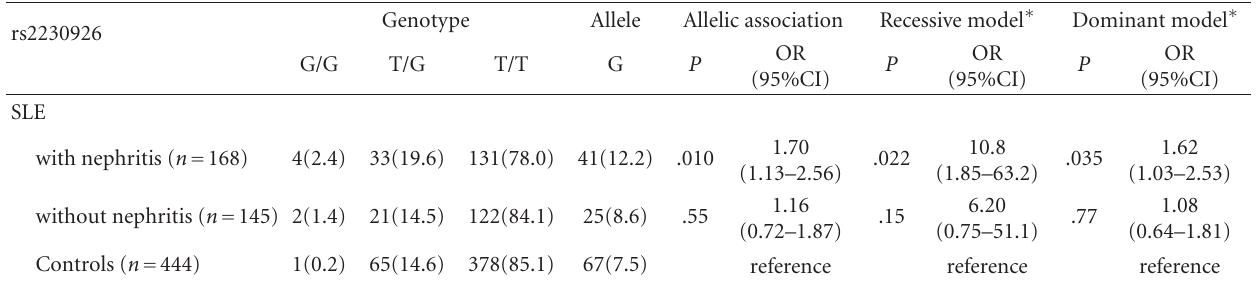
Table 2: Association of TNFAIP3 rs2230926 with presence or absence of nephritis.